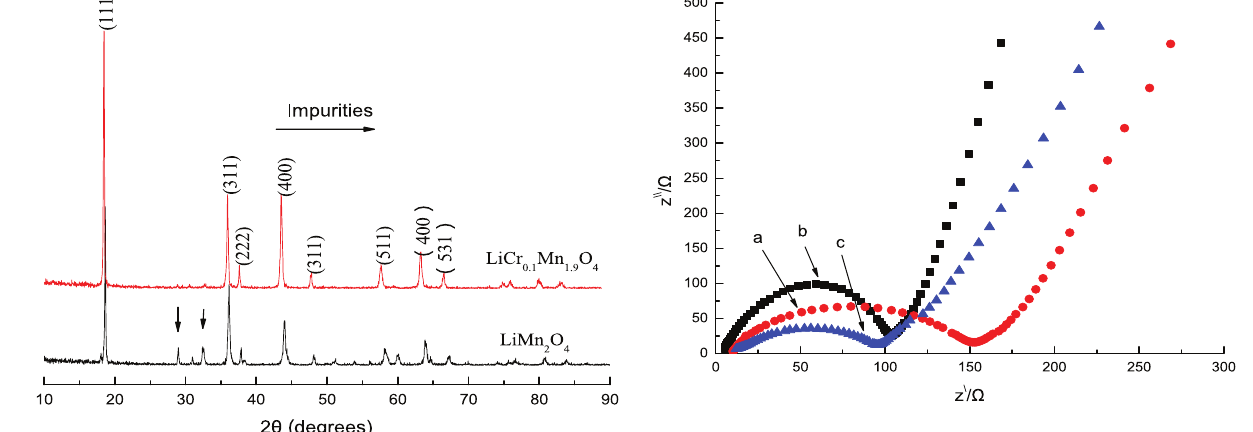
Fig. 2: EIS plots of a, b, c in initial charge process (a: 0 wt% carbon black coated, b: 2 wt% carbon black coated. c: 4 wt% carbon black